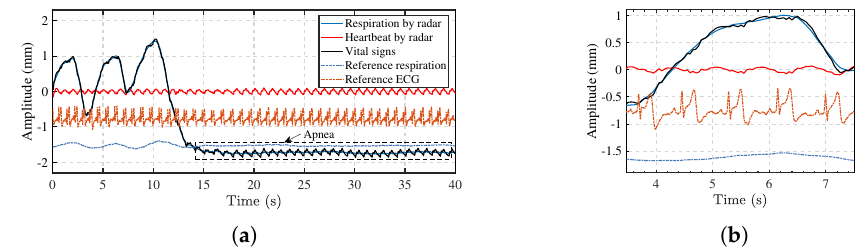
Figure 12. ( a ) Vital signs signal and separation results of Subject 2 with apnea. ( b ) Zoom of the respiration and heartbeat patterns extracted with radar and its associated reference